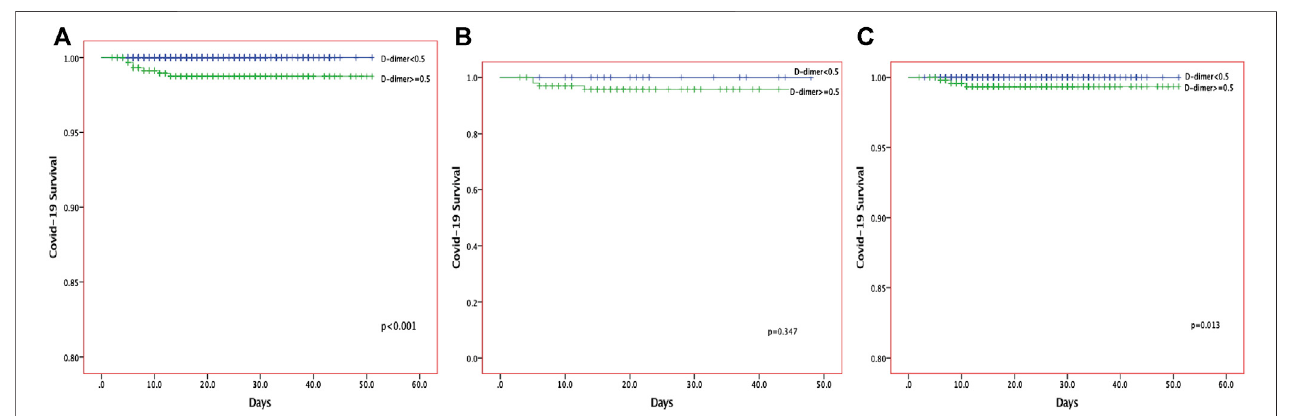
FIGURE 1 | The Kaplan-Meier curves of the survival of COVID-19 patients for all the COVID-19 patients (A) , anticoagulant group (B) and non-anticoagulant group (C) .